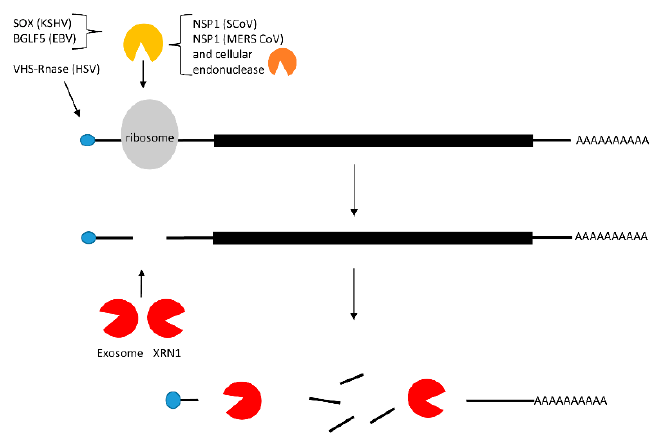
Figure 3. Endonucleolytic cleavage of mRNA in the 5 ′ UTR. Viral proteins SOX (Kaposi sarcoma herpes virus, KSHV), BGLF5 (Epstein Barr virus; EBV), VHS RNase (herpes simplex virus 1; HSV ‐ 1), and NSP1 (severe acute respiratory syndrome corona virus; SCoV) bind to the ribosome on translating mRNAs. RNA is cleaved in the 5 ′‐ UTR by viral or cellular endonucleases. Cleaved mRNAs are degraded by the exosome in the 3 ′ → 5 ′ direction, and by XRN1 5 ′ → 3 ′ .